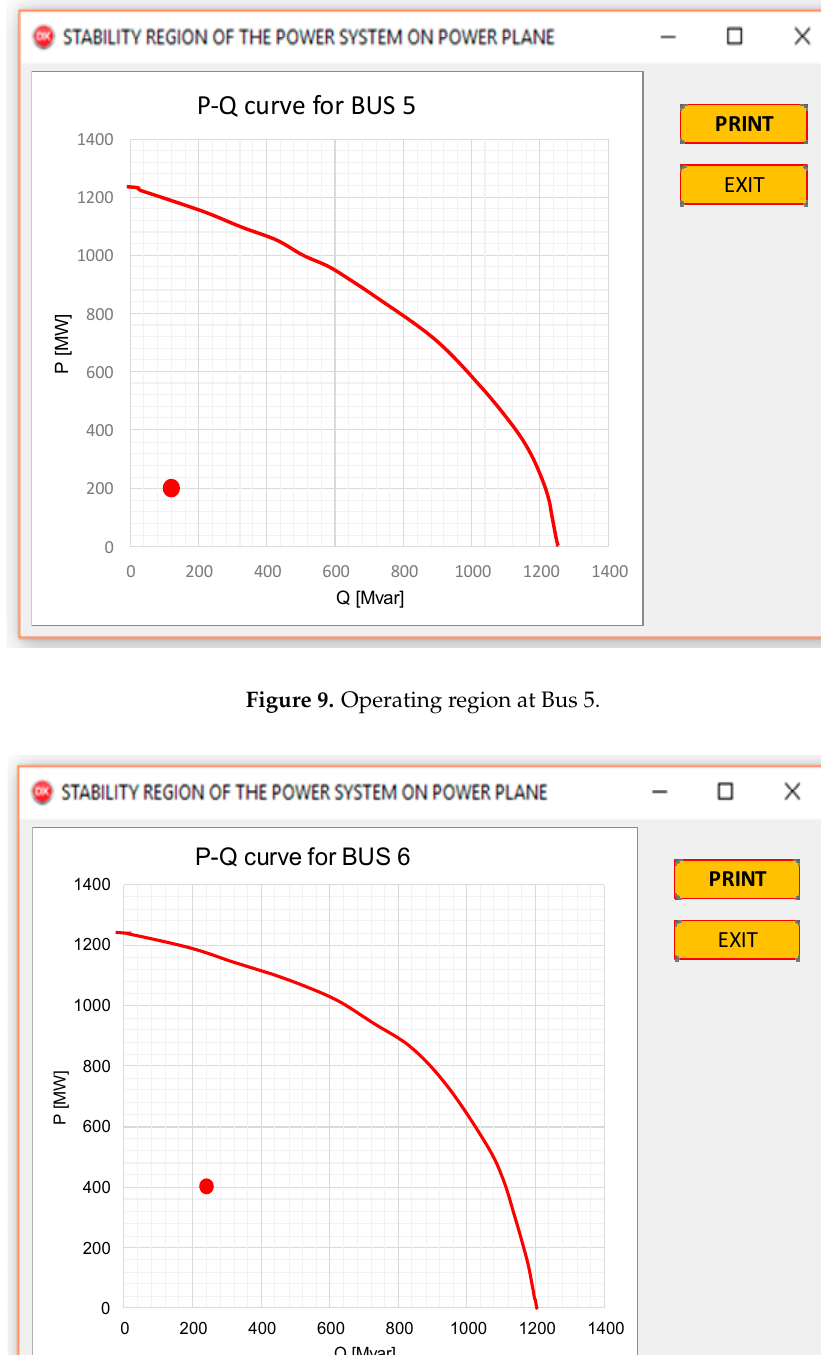
Figure 10. Operating region at Bus